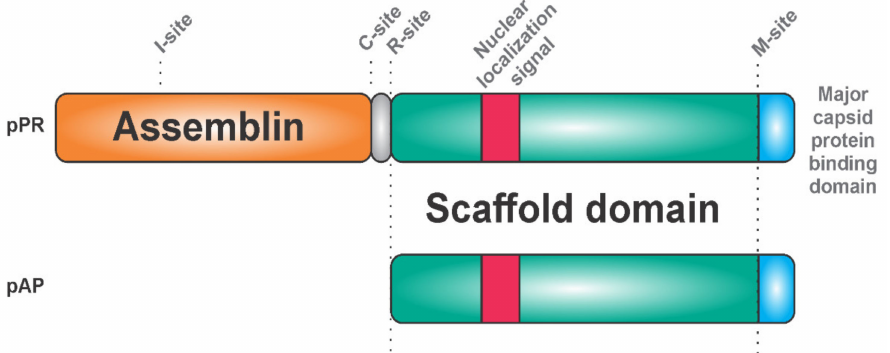
Figure 1. Herpesviruses: Two fusion proteins expressed from RNAs identical at the 3’-terminus, namely the protease precursor (pPR) embedding assemblin and the assembly protein precursor (pAP). The major capsid protein binding domain (blue) ensures the formation of a complex with the capsid protein. This complex is recruited into the cell nucleus via its nuclear localization sequence (red). Association of capsid proteins mediates the dimerization of assemblin, leading to its autoactivation. The scaffold protein is proteolytically processed at the M and R sites. The intra-assemblin processing sites I and C have regulatory